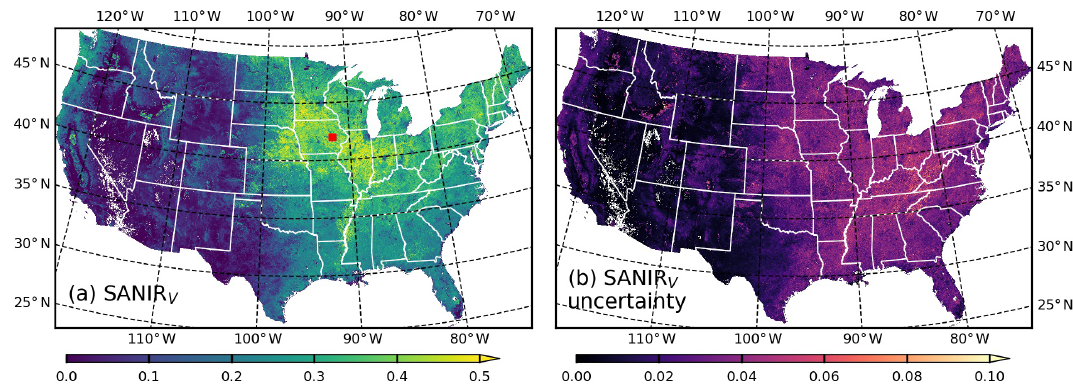
Figure 4. Spatial distribution of 250m resolution (a) SANIR V and (b) SANIR V uncertainty across the CONUS on 10 July 2020.